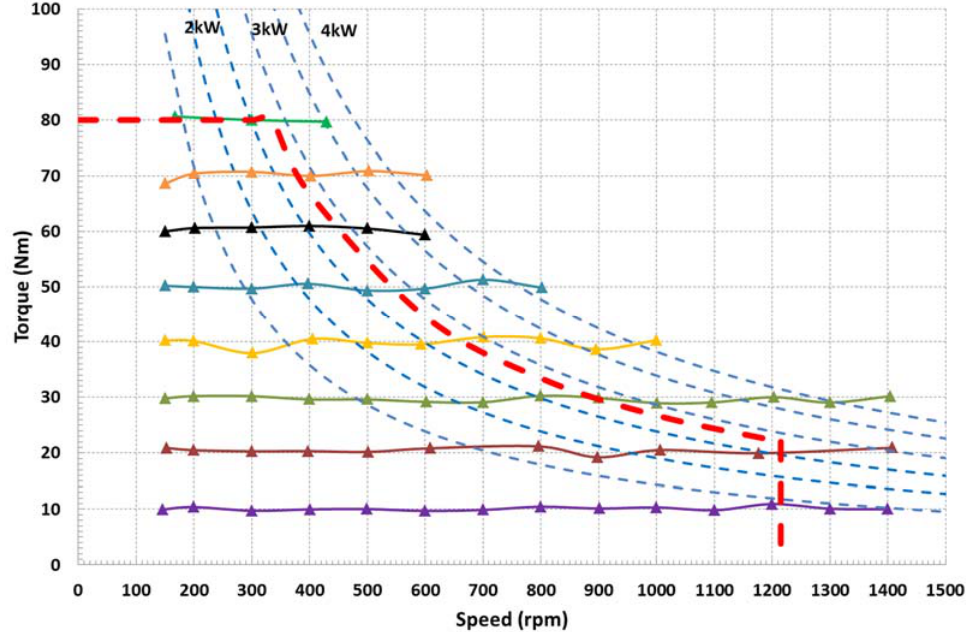
Figure 18. Torque ‐ speed curves experimentally obtained on the test rig. Drive requirements depicted by the red dashed line.